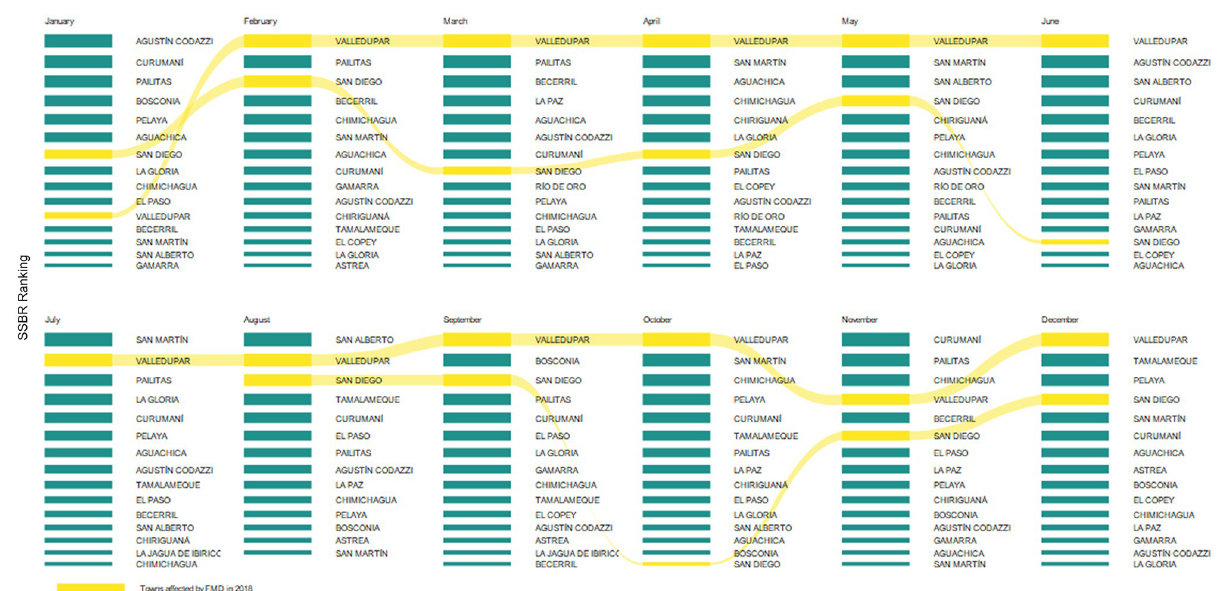
Fig 3. Network risk rankings computed for 2016 months. Each ranking corresponds to different municipalities displayed ordered depending on their level of risk. Yellow flow lines indicate the municipalities later affected by an outbreak in the same region in 2018.